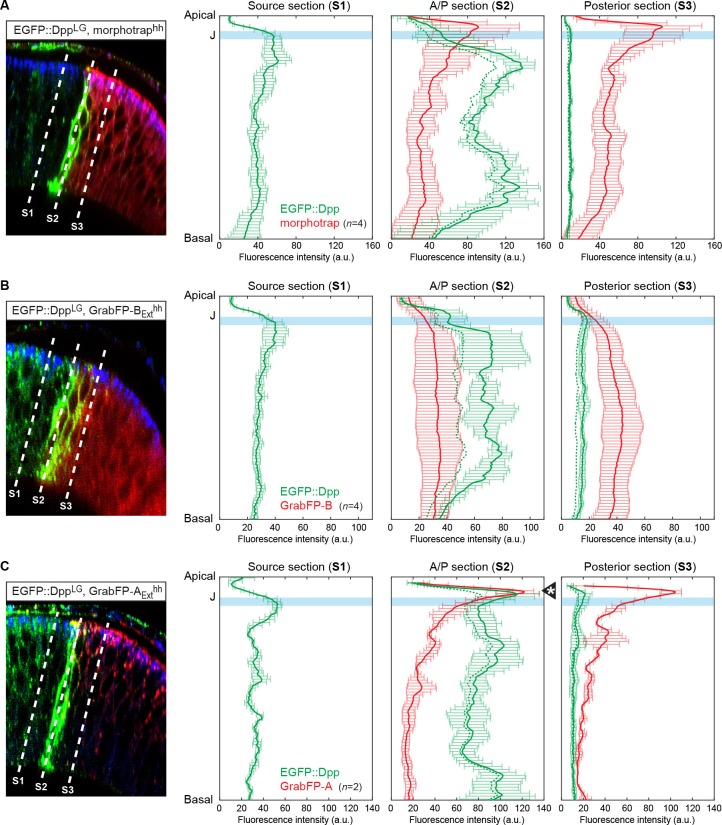
Quantification of differential eGFP-Dpp accumulation by morphotrap, GrabFP-BExt and GrabFP-AExt.eGFP-Dpp immobilization pattern along the A-B axis in the posterior compartment when either morphotrap (A), GrabFP-BExt (B) or GrabFP-AExt (C) are expressed in posterior cells (hh::Gal4). Left column: Optical cross-sections as shown in Figure 5. Positions at which eGFP-Dpp and GrabFPExt localization was measured are indicated by dashed lines (S1–S3). Middle-right column: Plots of average eGFP-Dpp (green line, corrected profile is shown as dashed line) and GrabFPExt (red) levels along the A-B axis as positions indicated in the left column. eGFP-Dpp levels are strongly increased along the A/P boundary (S2 section) in all conditions. Importantly, neither morphotrap (A, middle-right) nor GrabFP-BExt (B, middle-right) immobilize eGFP-Dpp in the apical compartment above the junctions (thick blue line). In contrast, GrabFP-AExt shows strong eGFP-Dpp immobilization in the apical compartment (arrowhead in C, middle-right). This might be due to GrabFP-AExt mediated mislocalization of basolateral eGFP-Dpp to the apical compartment. In all conditions eGFP-Dpp levels drop after the first 2–3 cell rows (green in S3) suggesting that indeed posterior GrabFPExt expression results in impaired posterior Dpp dispersal. In the plots, thick lines represent average fluorescence values and error bars show the standard deviation.